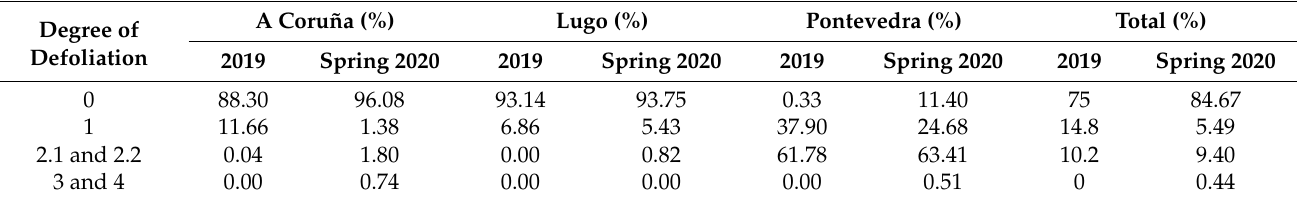
Table 4. Percentage of area with degrees of defoliation according to the GOSSGE protocol for the three provinces in Galicia with damage in 2019 and spring 2020.